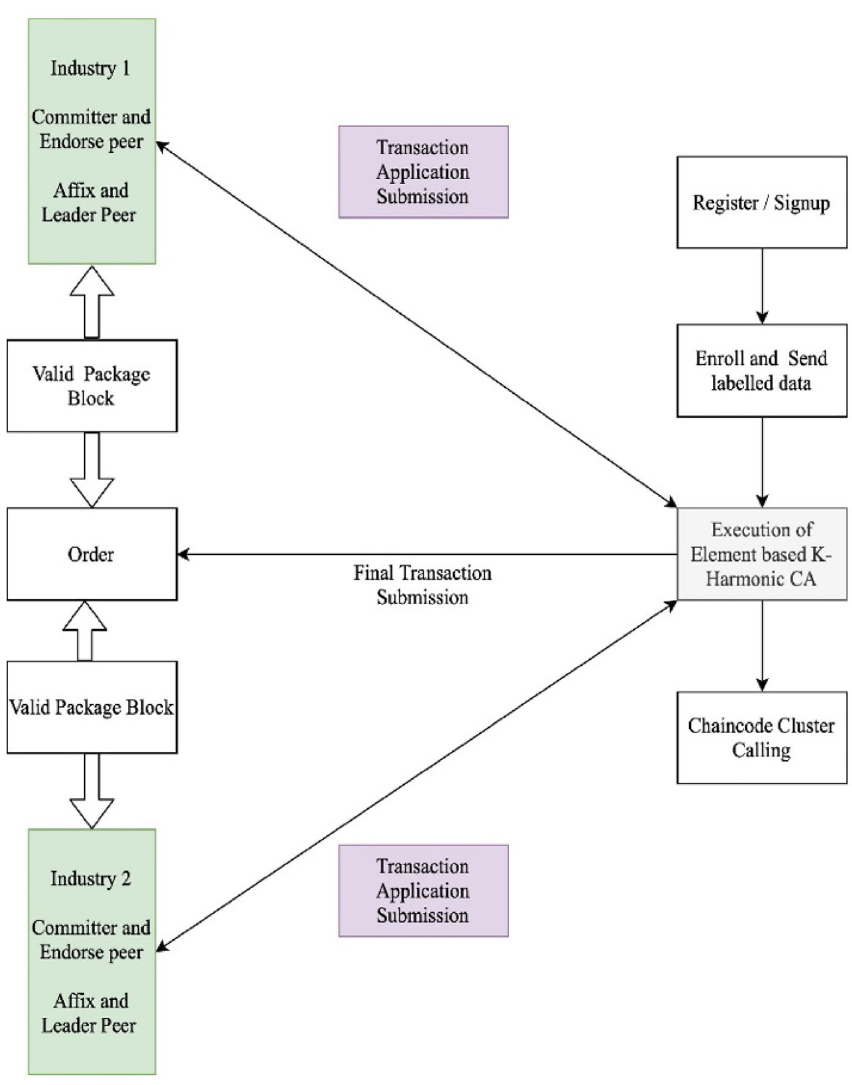
Figure 5. Blockchain-based communication process with